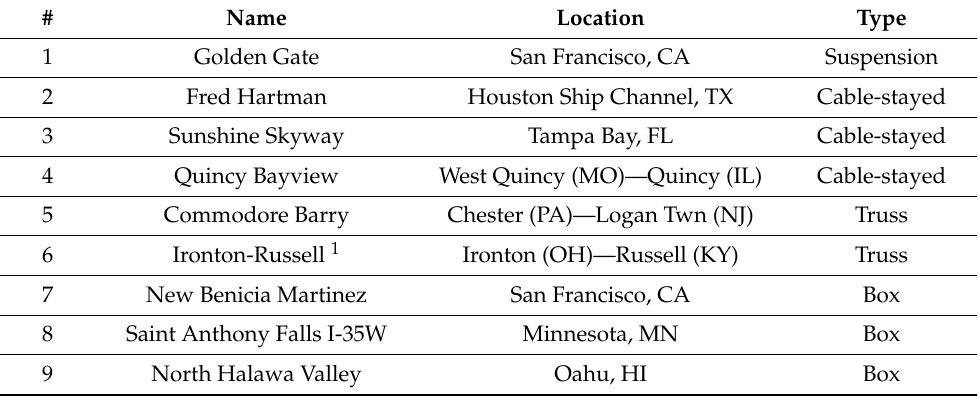
Table 1. Bridges in the United States instrumented with sensing systems prior to 2011 according to Table 1.1 of ref.